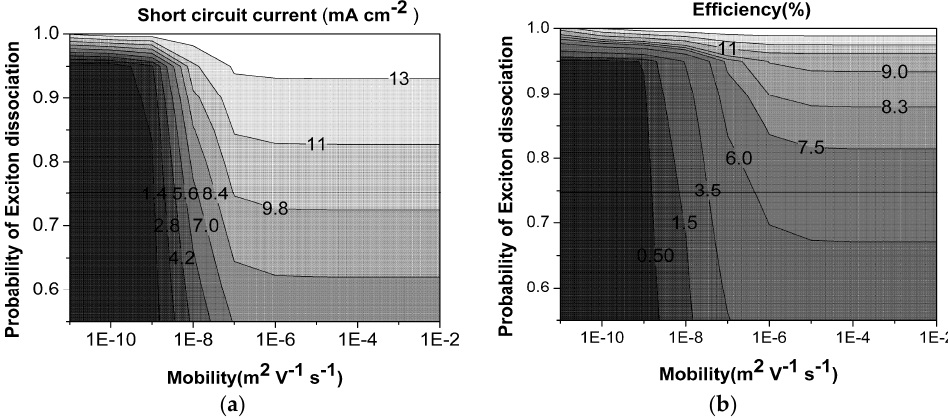
Figure 8. Counter plot of ultimate ( a ) J sc and ( b ) PCE as a function of balanced mobility vs. exciton dissociation probability.